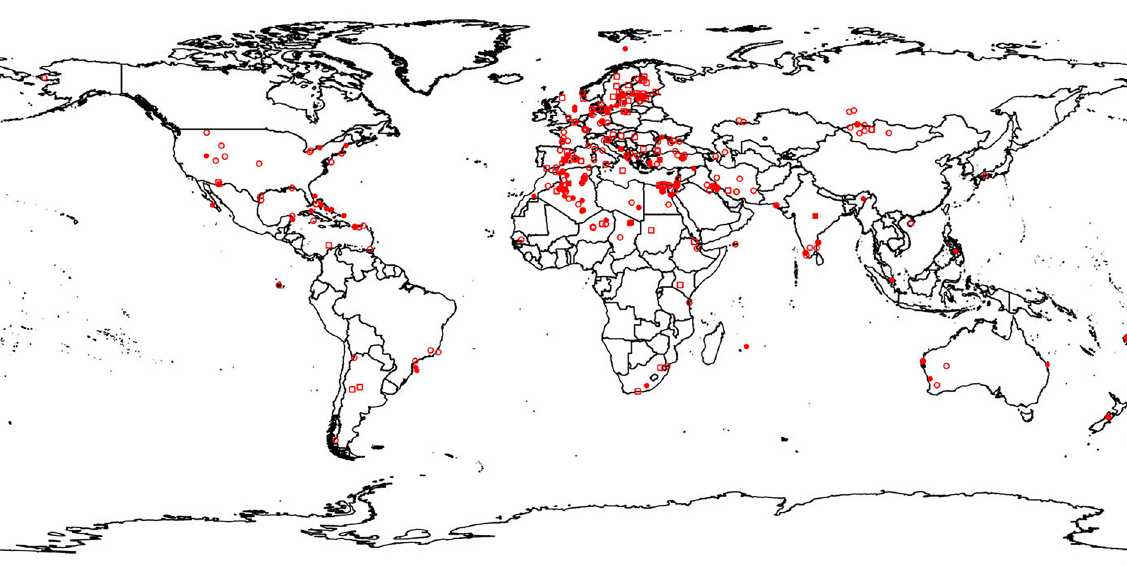
Fig. 69. World distribution of Mastogloia braunii s. lat. according to the literature. Circles: recent records. Squares: fossil records. Filled symbols indicate confirmed (illustrated) records. 331 locations were found based on 271